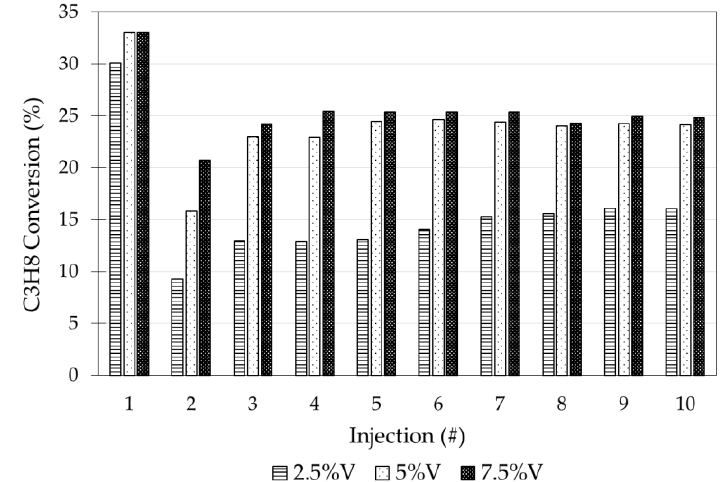
Figure 5. Propane Conversion during Consecutive Oxidative Dehydrogenation (ODH) Cycles over Various (2.5, 5, and 7.5 wt.% V) VO x /ZrO 2 - γAl 2 O 3 Catalysts (Operating conditions: T = 550 °C, reaction time = 20 s, C 3 H 8 injected = 10 mL, catalyst loaded = 0.76 g). Standard deviations for repeats: 1.5%. Note: Reported values are based on propane conversion into carbon containing gas phase products. Adapted with permission from [59], copyright 2017, American Chemical Society.